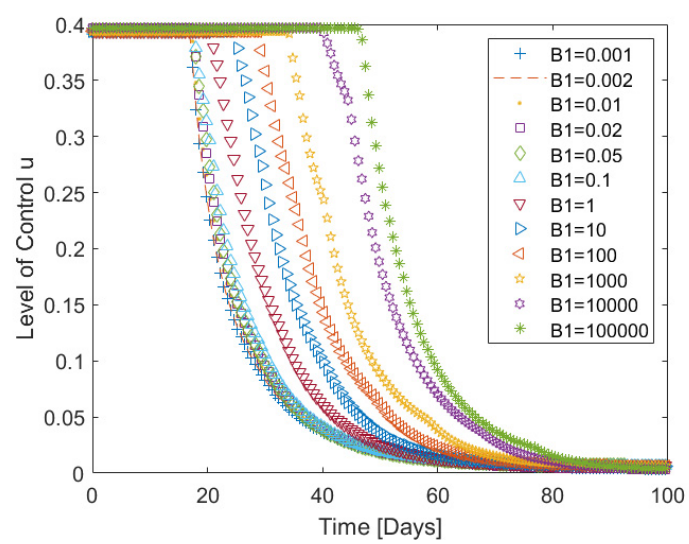
( ) u t B of Equation (19). against the changes in 1